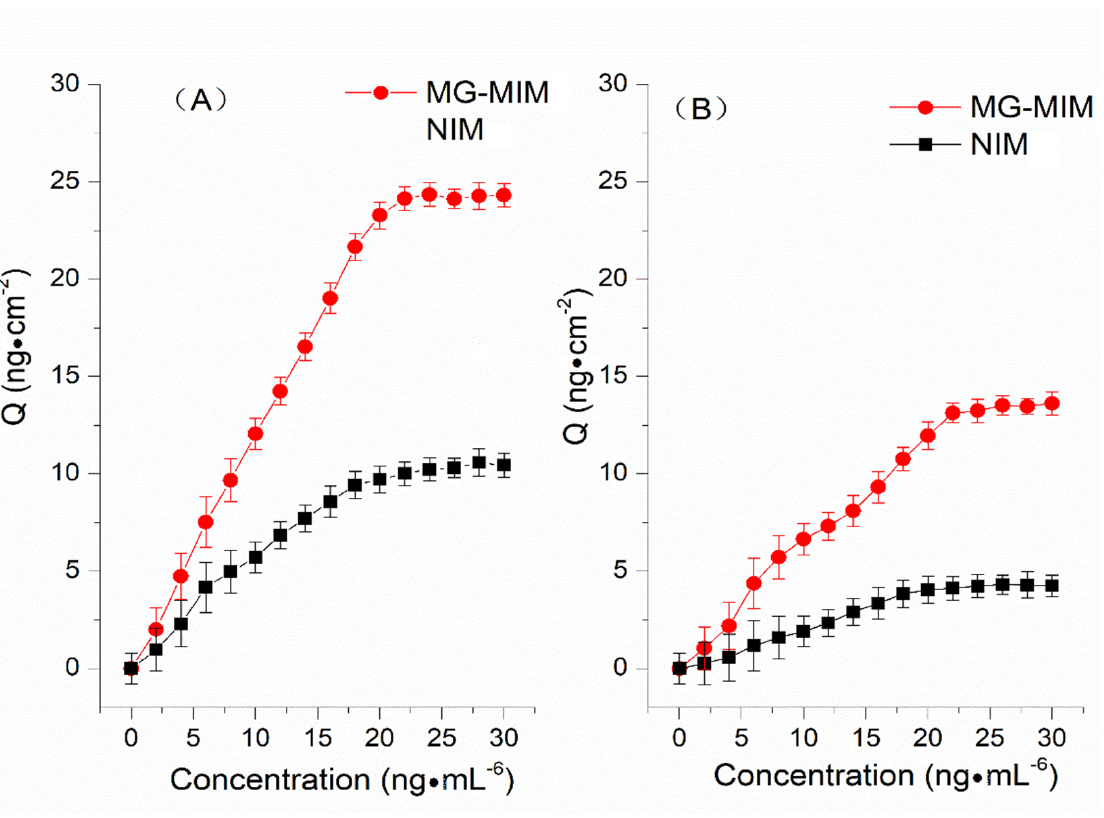
Figure 6. Adsorption isotherm curves of MG ( A ) and LMG ( B ).